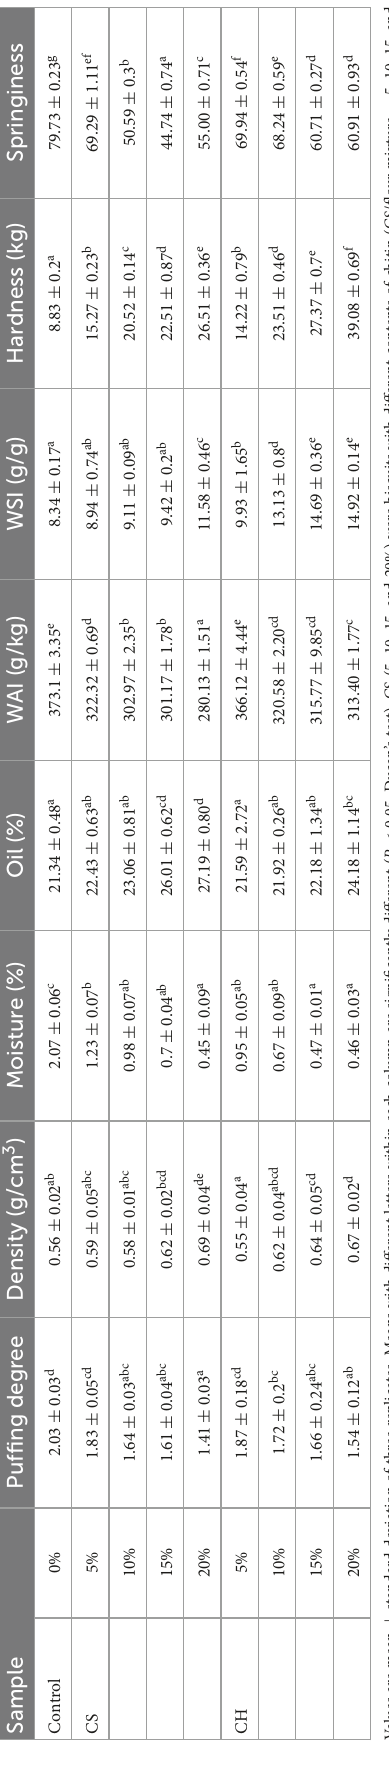
The textural changes of puffed biscuits fortified with different levels of chitin or crayfish shell are presented in Table 2